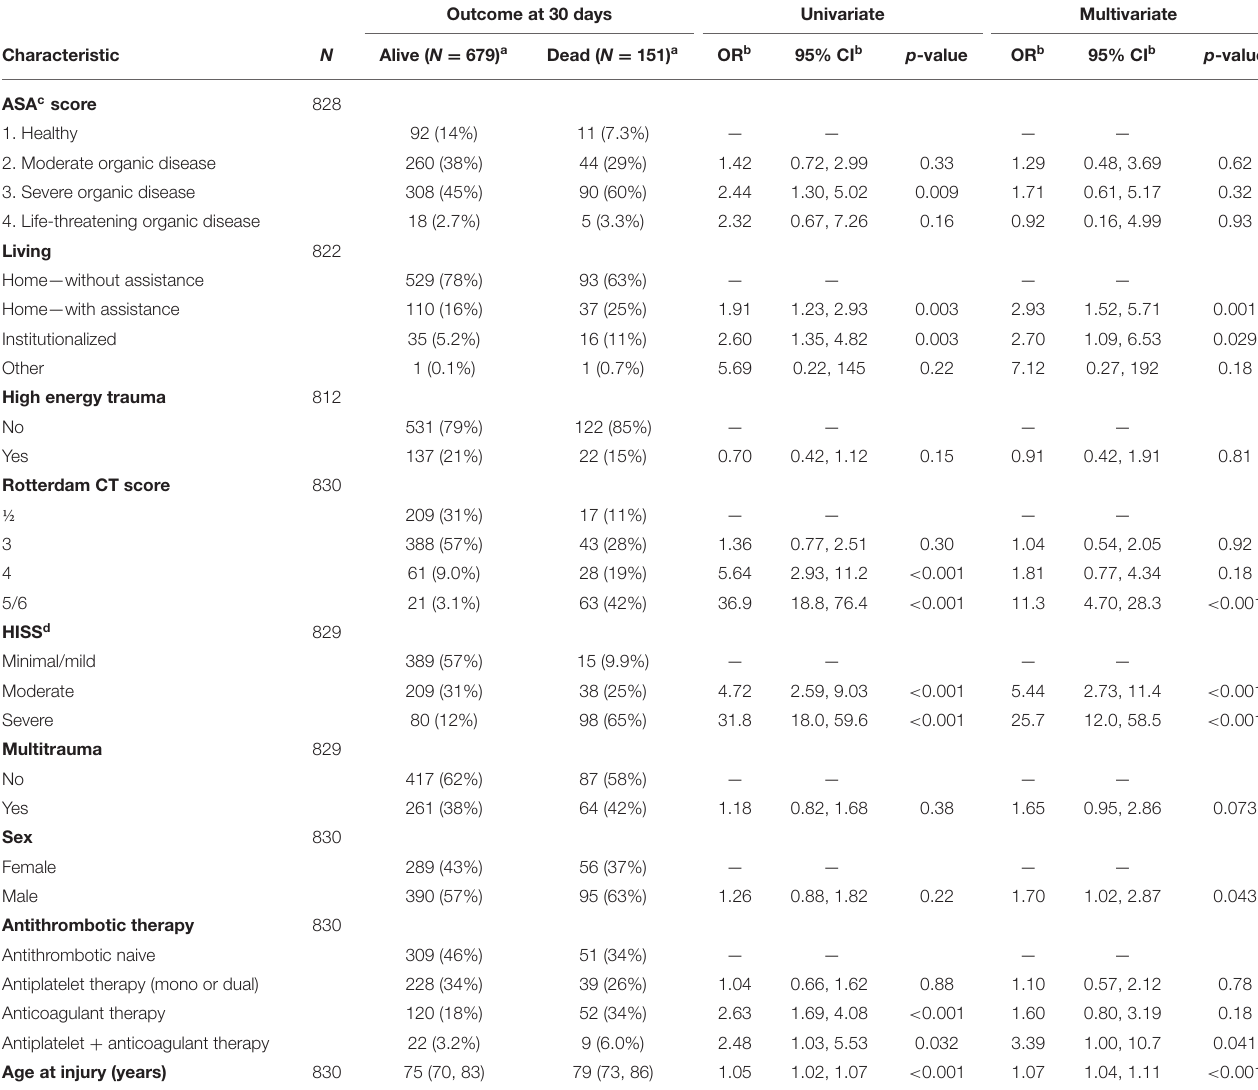
TABLE 5 | Logistic regression for 30-days outcome. Outcome at 30 days Univariate